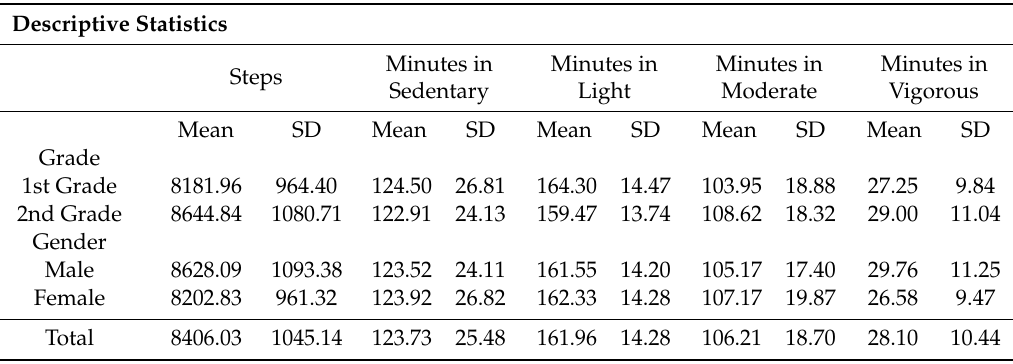
Table 1. Descriptive Statistics. Means and standard deviations of moderate and vigorous physical activity (MVPA) and steps for grade, gender, and